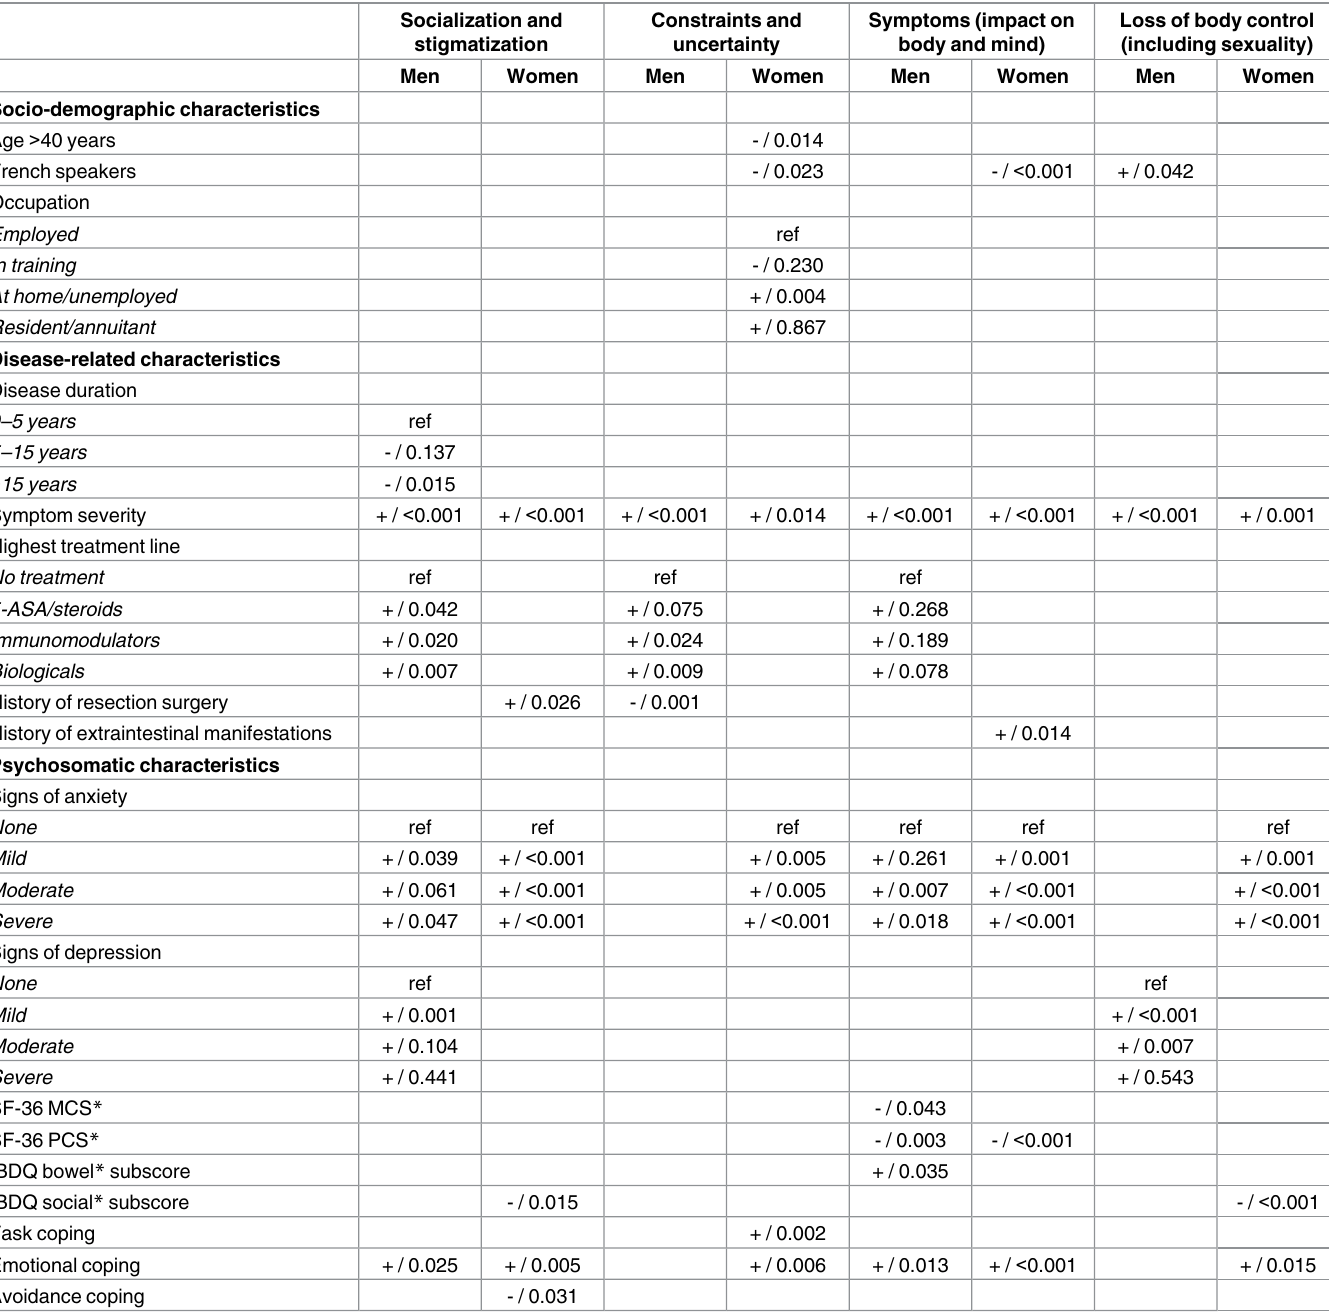
Table 4. Multiple linear regressions for each concern dimension stratified by gender. Valuesindicate the direction of the associationand the